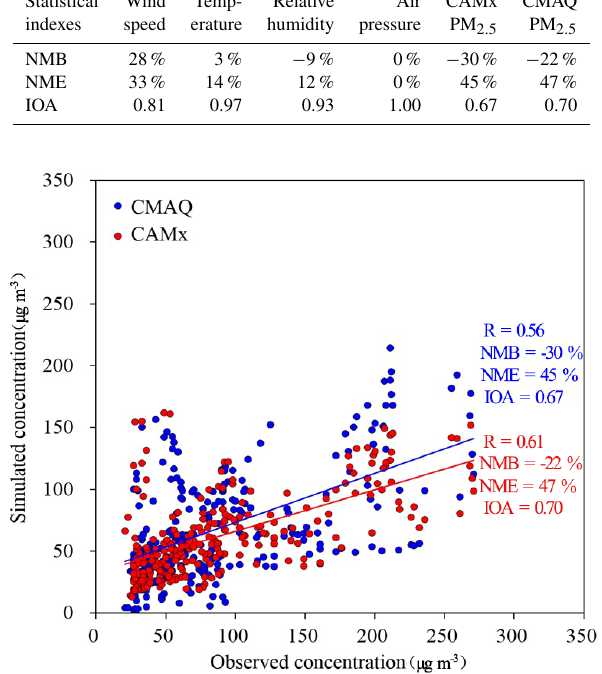
Figure 3. Scatter plot of the simulated and observed PM 2 . 5 at the Shanxi